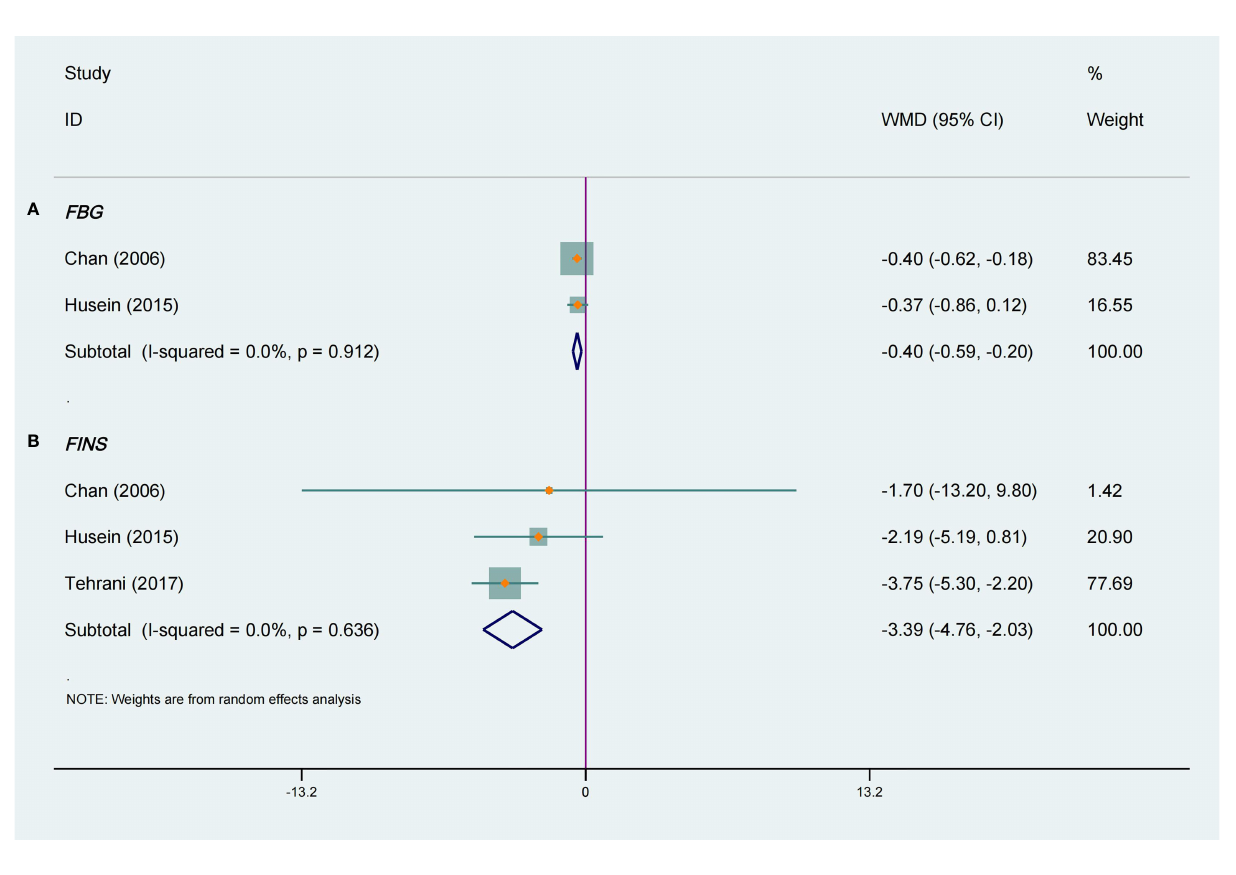
FIGURE 4 | Meta-analyses of the effect of tea supplements on metabolic parameters. (A) FBG and (B)